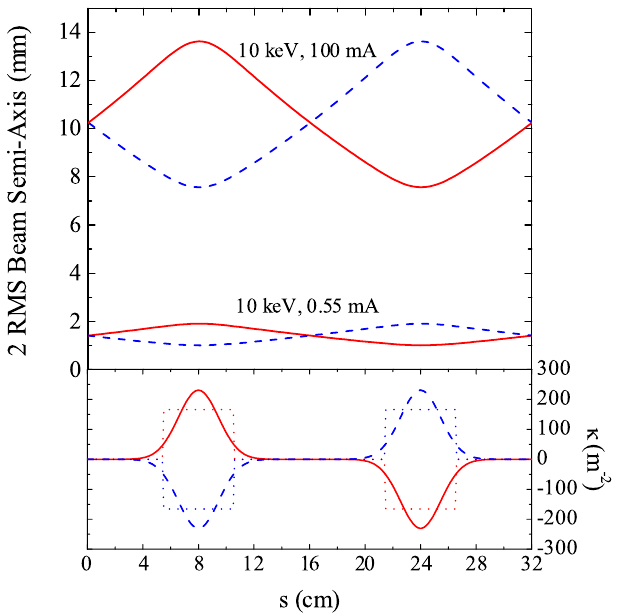
FIG. 5. (Color) Beam envelopes in a unit FODO cell in UMER (cid:5) 72 : 92 (cid:12) . Periodic-matched solutions from the envelope for (cid:5) 0 code SPOT are shown for extreme space-charge dominated (top) and emittance-dominated (bottom) electron beams (see Table I). The focusing function is proportional to the gradient g (cid:1) s (cid:2) of Eq.